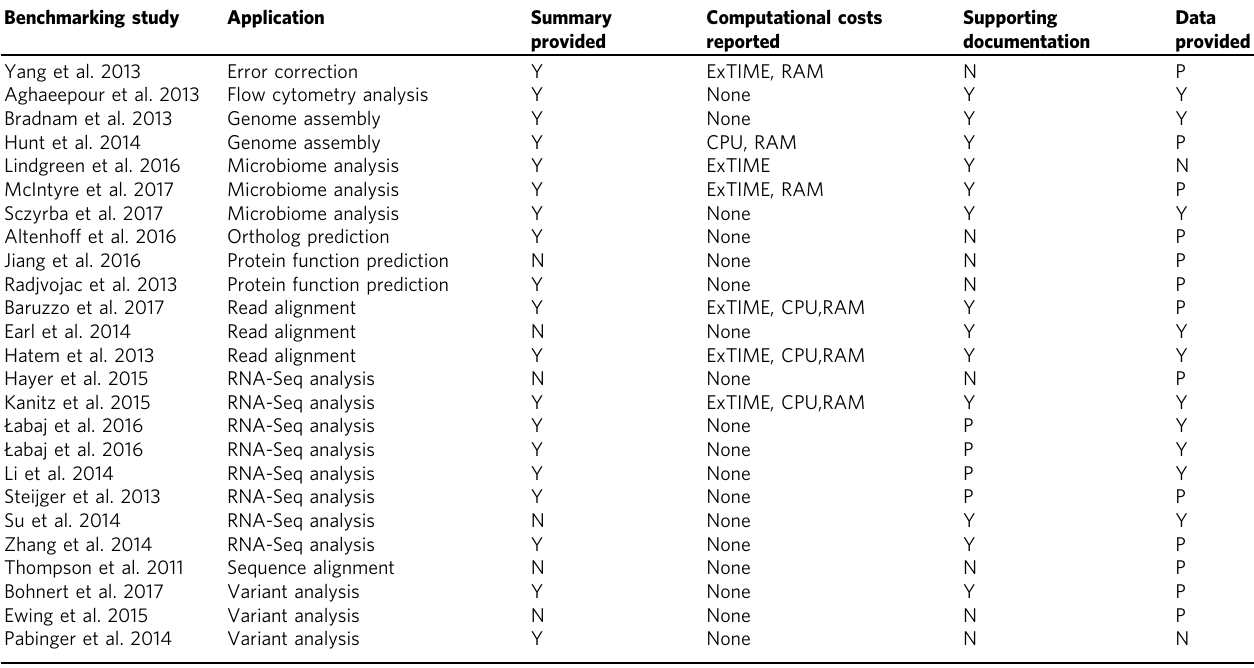
Table 3 Summary of information types provided by benchmarking